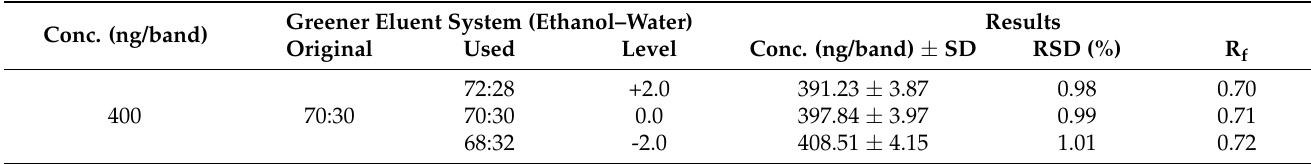
Table 5. Findings of FFA robustness for the ecofriendly HPTLC assay (mean ± SD; n = 6).